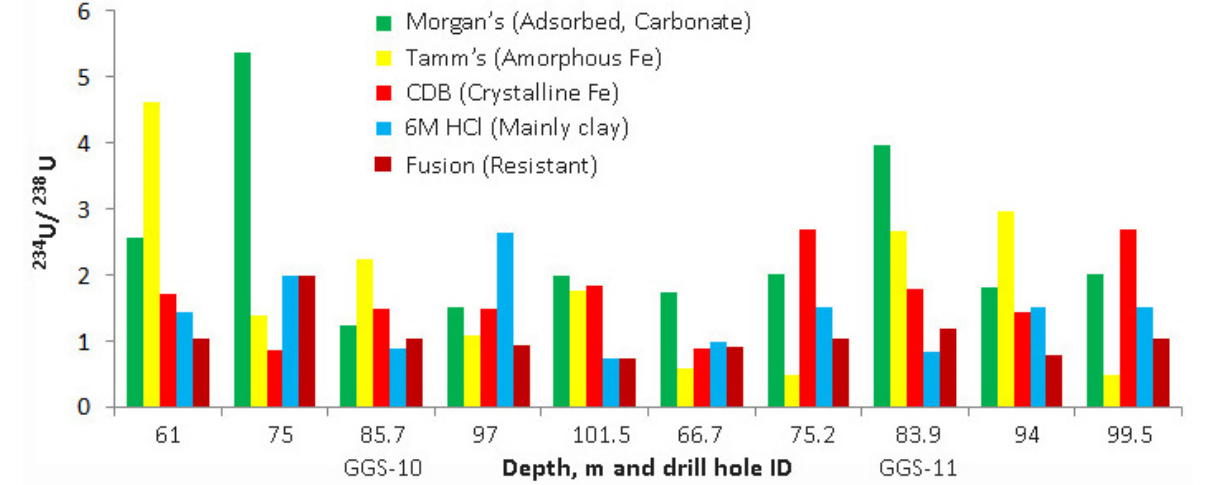
Figure 5. Measured 234 U: 238 U activity ratios in extracted phases.